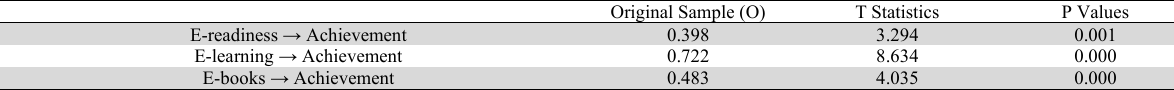
The summary of testing the